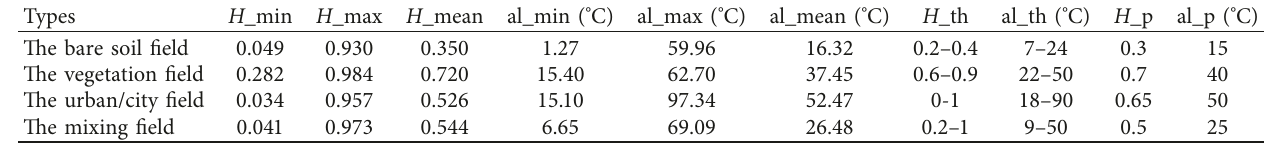
Table 2: Values obtained when evaluating surfaces differing in terms of cover.